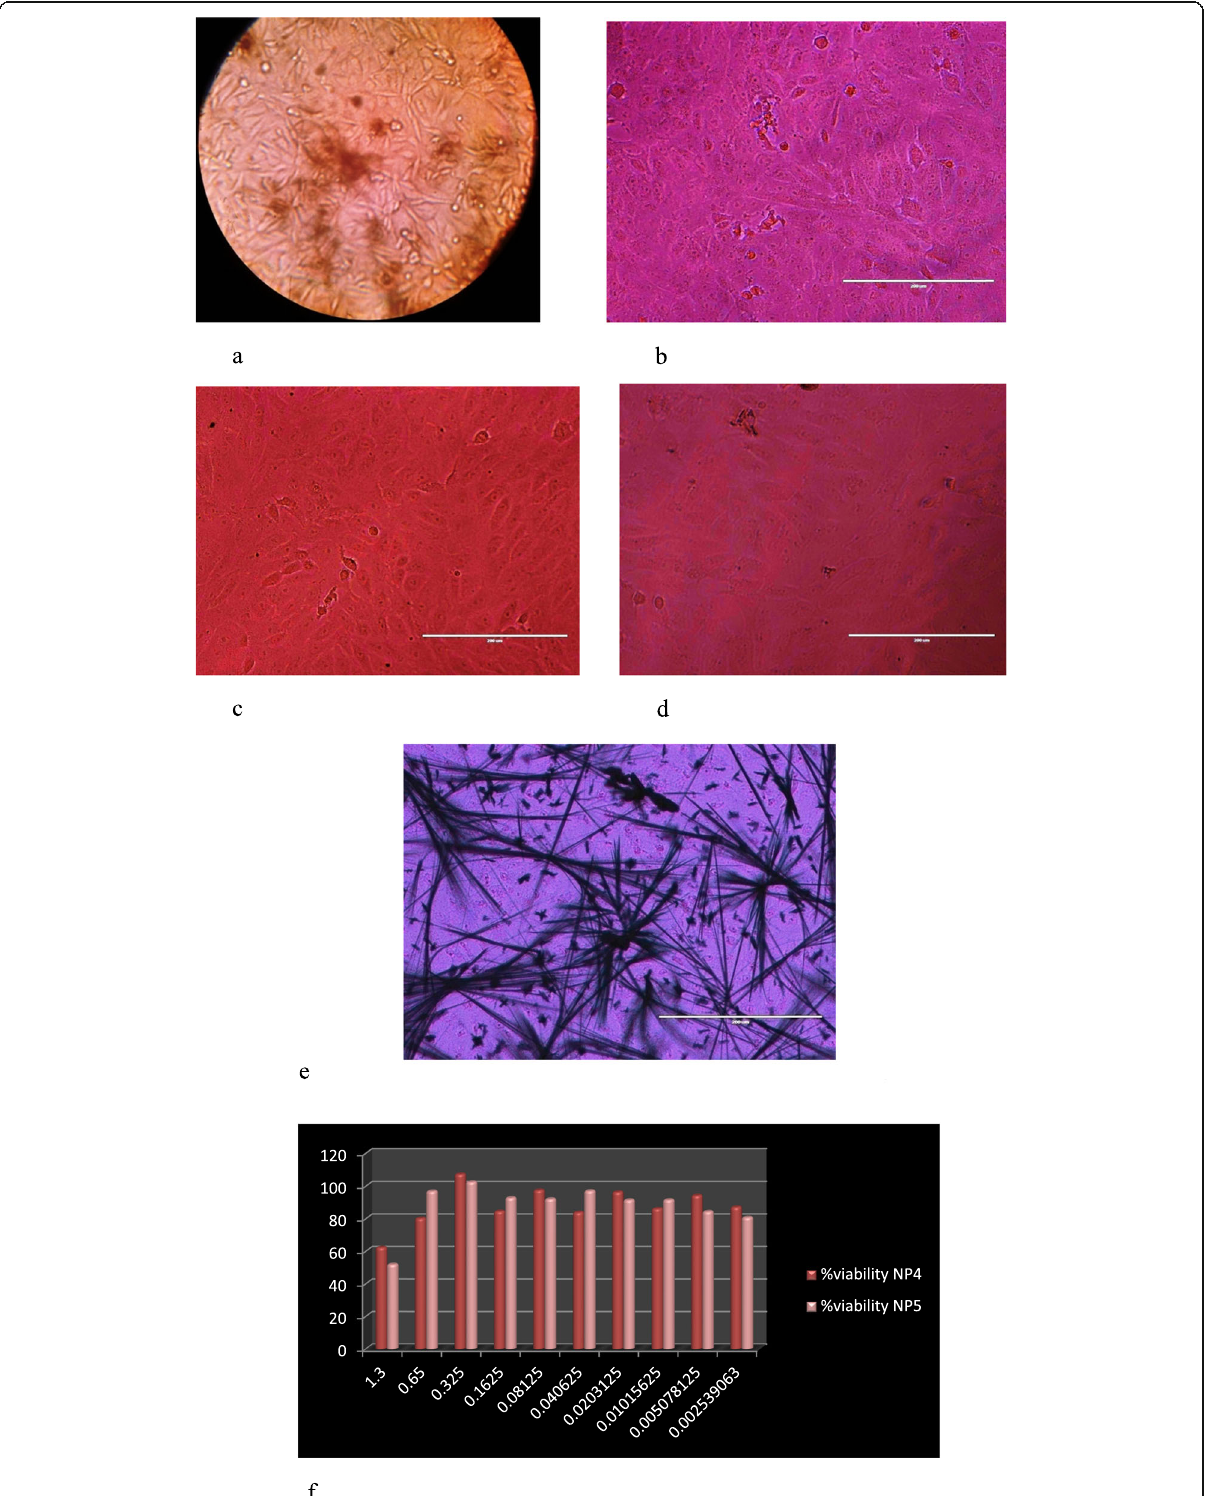
Fig. 6 a VERO cell line. b Control cell after 24 h. c After treated with AMNP1. d After treated with AMNP2. e The formazan crystals formed in treated VERO cells followed by MTT dye incubation. f Viability % in treated VERO cell